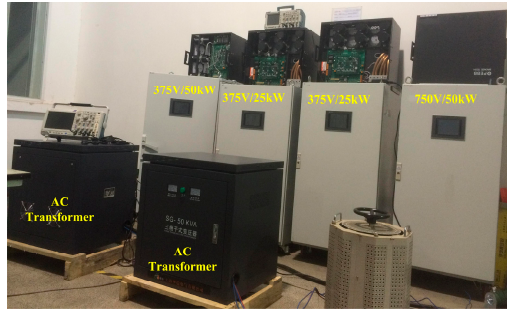
Figure 9. Photograph of the experimental set-up for UUDAT and DUDAT.